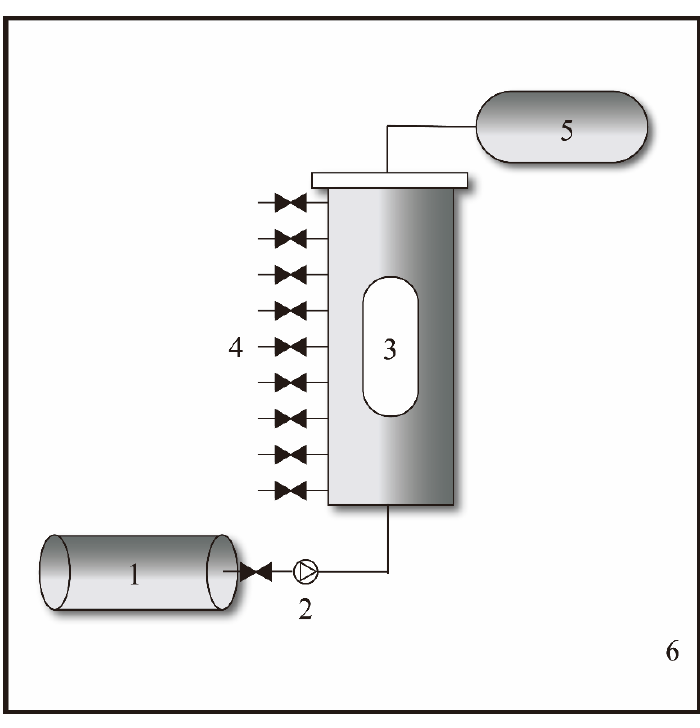
Figure 1. Biogeochemical simulation experiment device.